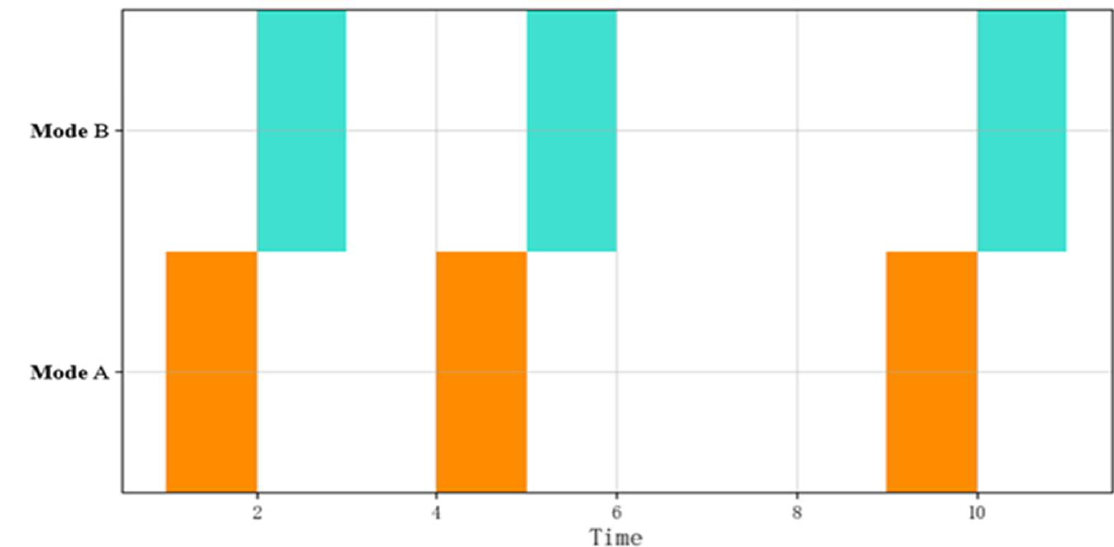
Figure 5. Visualization of the event flow iteration composition. (4)